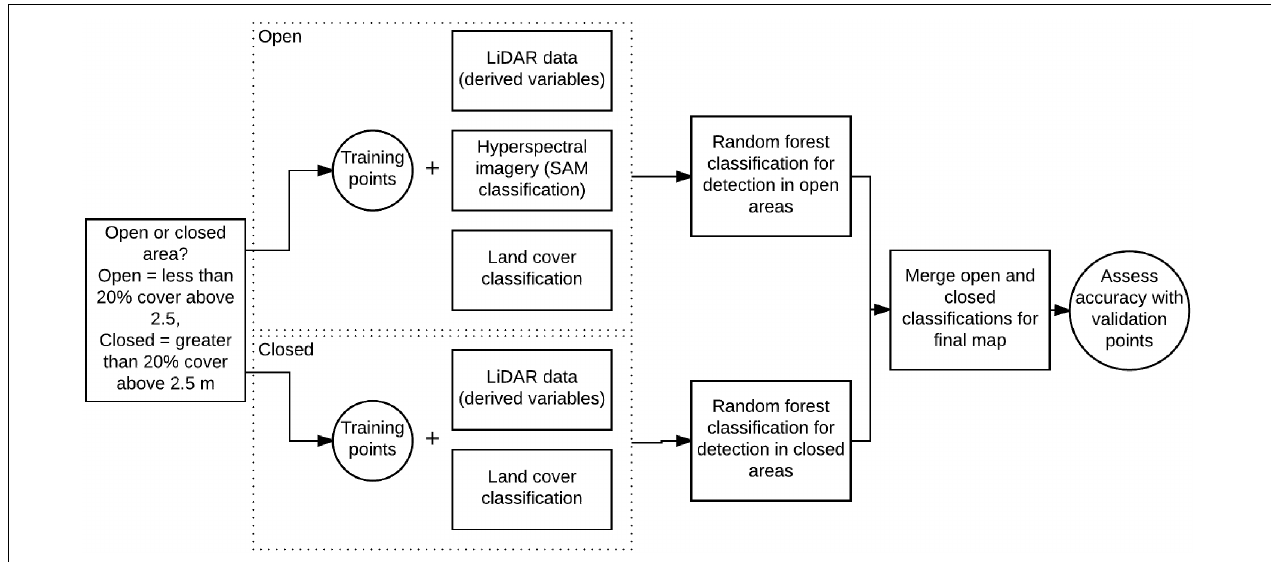
FIGURE 1 | Flow diagram showing the use of the LiDAR data, hyperspectral imagery, and field data to detect Himalayan blackberry ( Rubus armeniacus ) and English ivy ( Hedera helix ). SAM, spectral angle